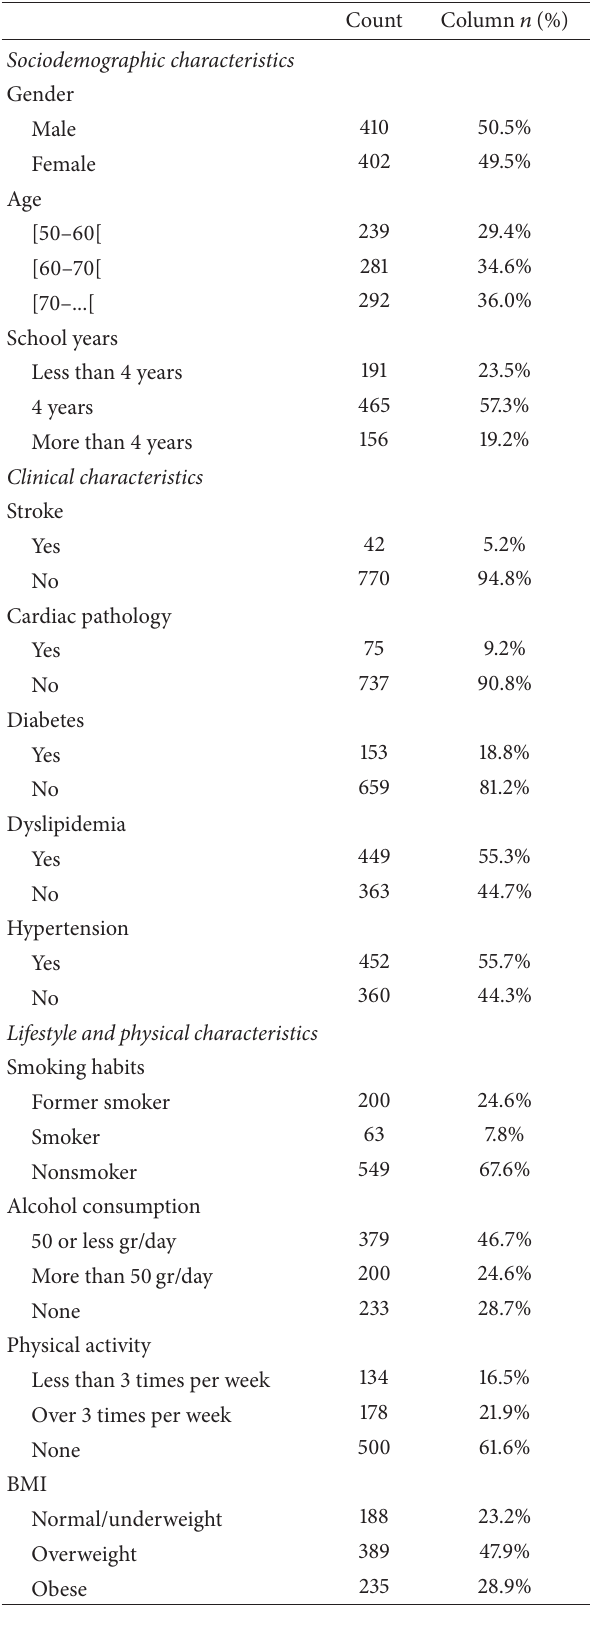
Table 1: Clinical, general lifestyle, physical, and cognitive character-